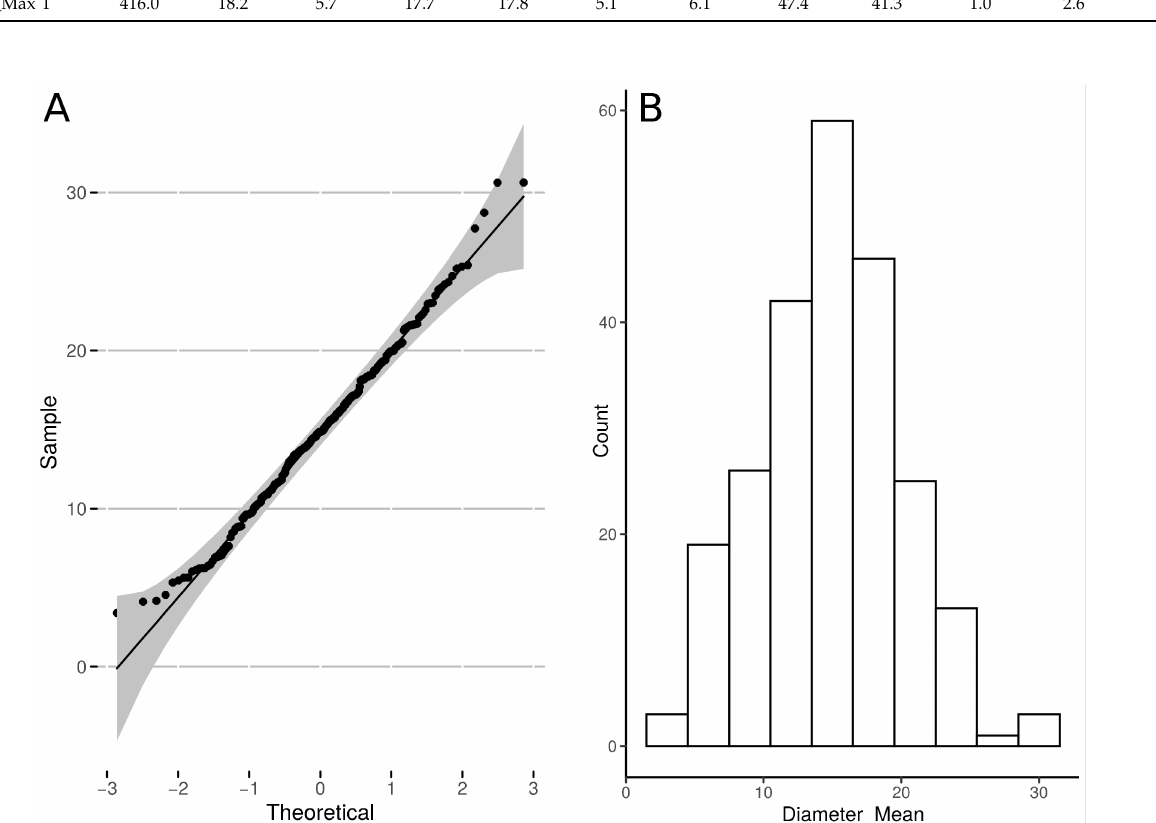
Figure 5. Particle analysis of TEM images of washed sample at pH 6 (the pH was adjusted before the preparation of the AuNPs). The probability plot ( A ) and histogram ( B ) confirmed an approximately normal distribution of the mean diameter of the